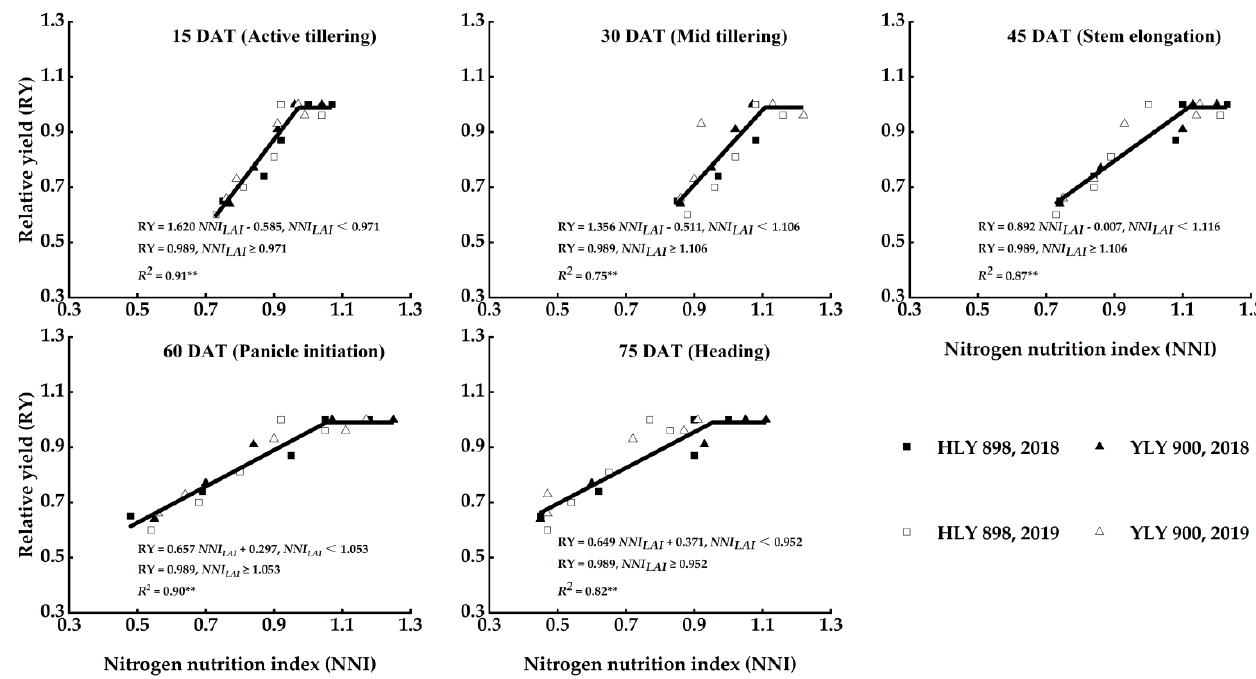
Figure 9. Relationship between the nitrogen nutrition index ( NNI LAI ) and relative yield (RY) in the different growth stages, shown for the varieties Huiliangyou 898 (HLY 898) and Yliangyou 900 (YLY 900) according to the season (2018 or 2019). DAT, days after transplantation. ** indicates significance at the 0.01 level.